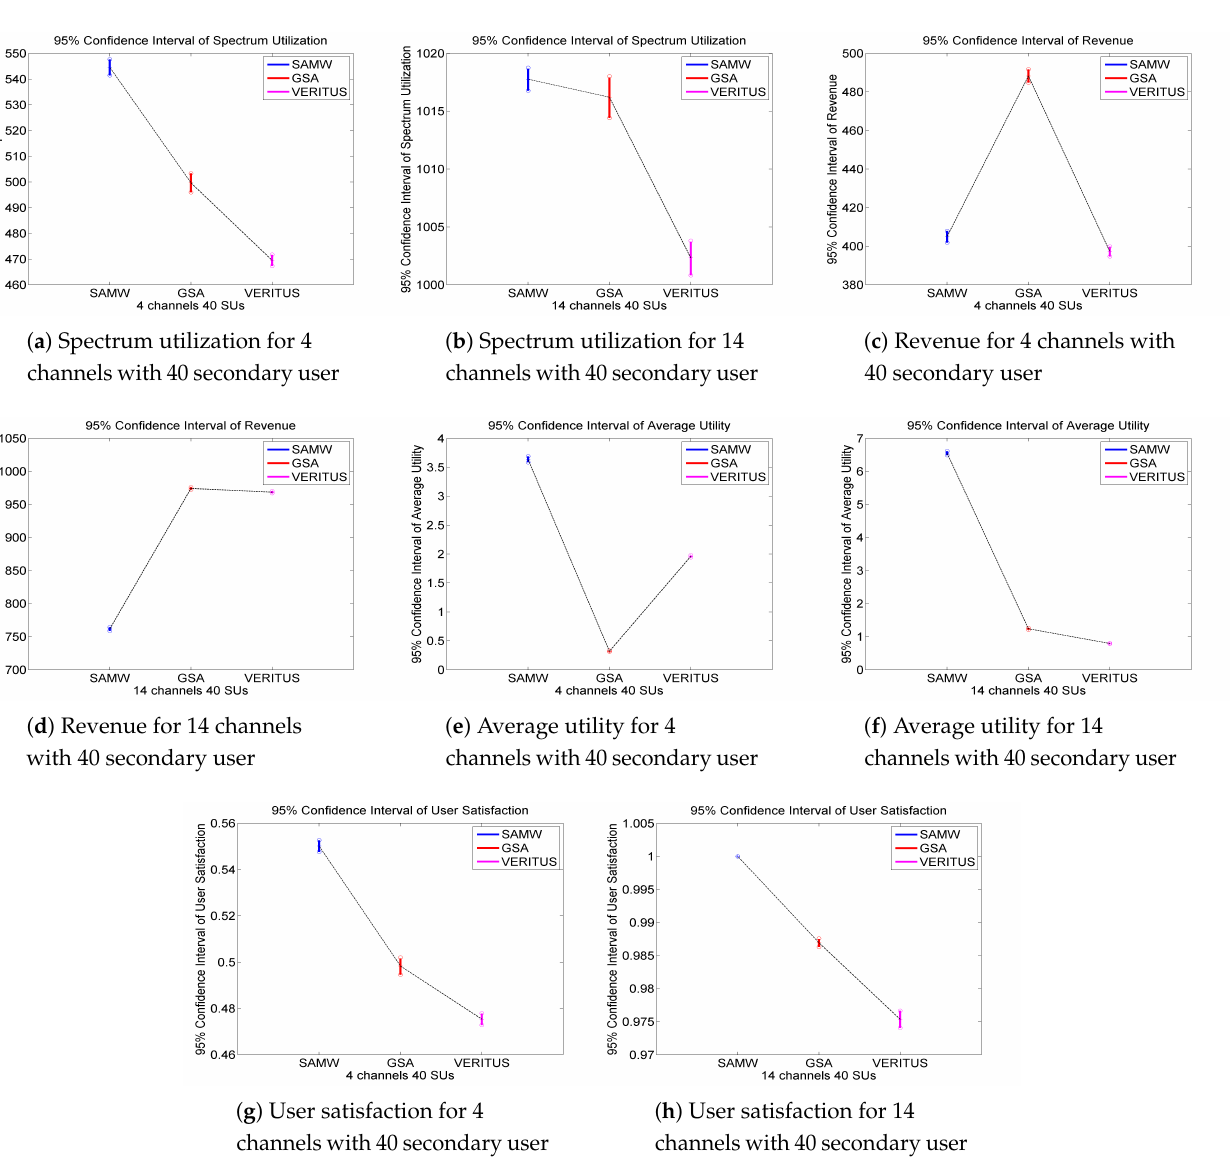
Figure 7. Confidence intervals at 95% confidence level for spectrum utilization, revenue, average utility and user satisfaction for 4 channels with 40 secondary users (SUs) and 14 channels with 40